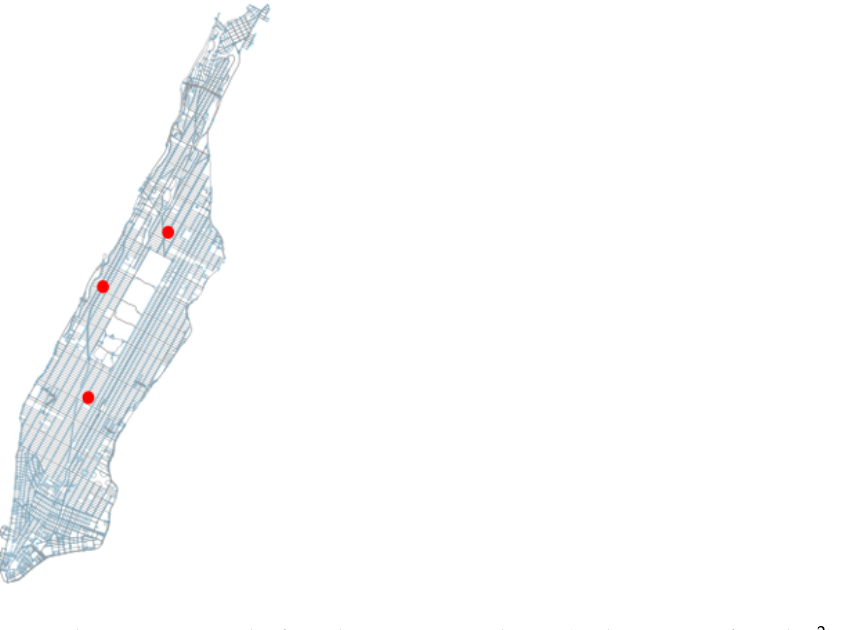
Figure 6. Urban street network of Manhattan, New York City (with area size of 59.1 km 2 ), obtained from OpenStreetMap via OSMnx Python library [51]. The three red dots represent the (approximate) location of the chosen drone depots in our